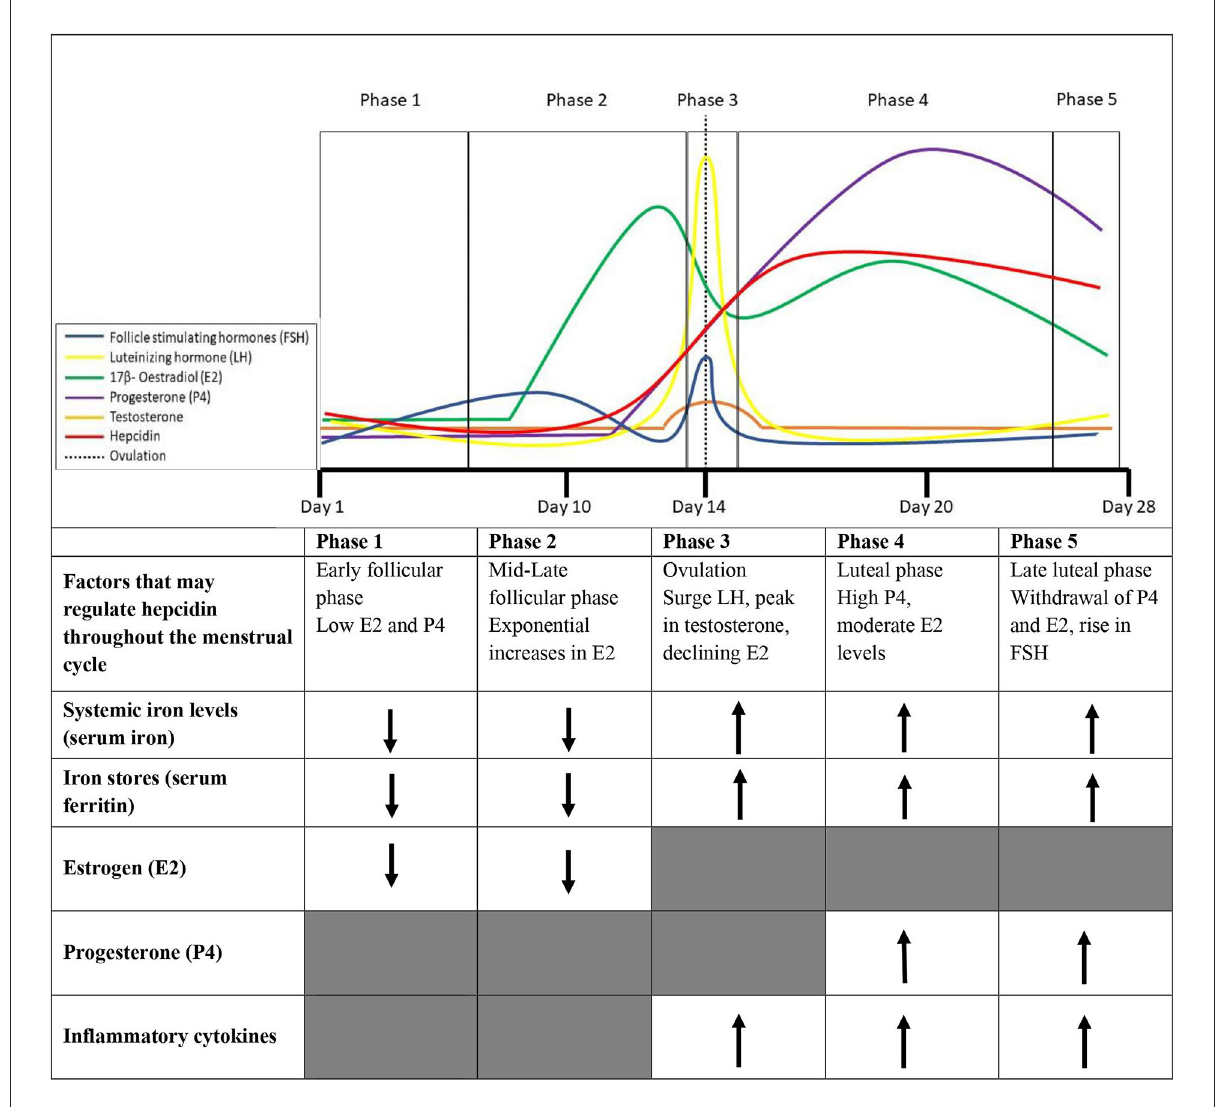
FIGURE1 Phases of the menstrual cycle and factors that collectively may contribute to the variability in hepcidin expression throughout the menstrual cycle in healthy eumenorrheic iron sufficient (serum fcrritin > 35 µ g/L) females.